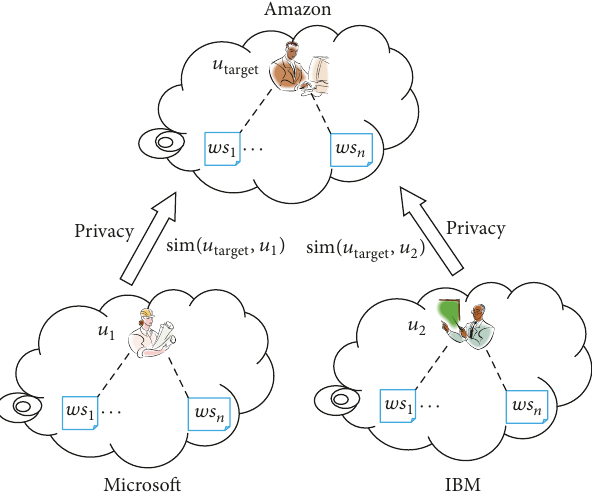
Figure 1: Cross-cloud service recommendation: an